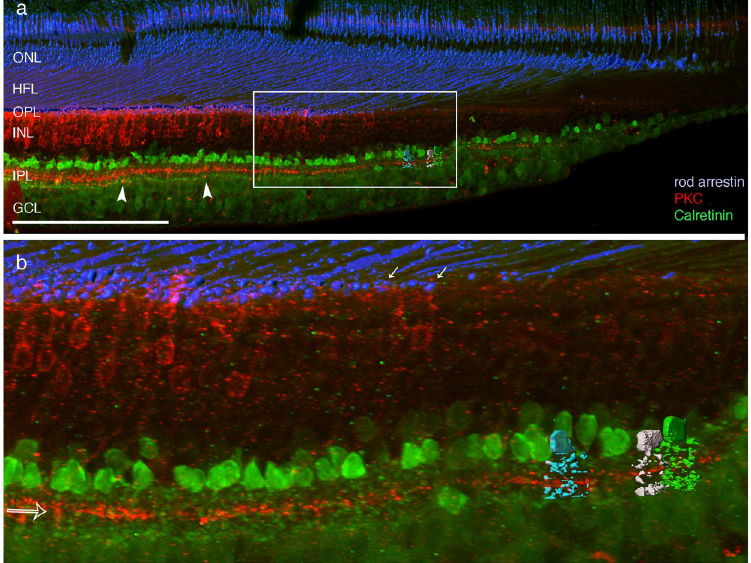
Figure 4. Rod pathway neurones in human fovea. ( a,b ) Confocal images of a vibratome section through the fovea that was processed with antibodies against rod arrestin to reveal rods (blue), antibodies against protein kinase C (PKC, red) to reveal rod bipolar cells and antibodies against calretinin (green). Rods are shown in 3d reconstruction. The arrowheads point to PKC labelled rod bipolar axon terminals. ( b ) Shows the region outlined in a. Three calretinin positive cells are reconstructed and have AII morphology. The open arrow points to the PKC labelled band formed by DB4 axons. The white arrows point to the first rod spherules appearing in the fovea. ONL, outer nuclear layer; HFL, Henle fibre layer, OPL, outer plexiform layer; INL, inner nuclear layer; IPL, inner plexiform layer; GCL, ganglion cell layer. Scale bar shown in a = 200 µ